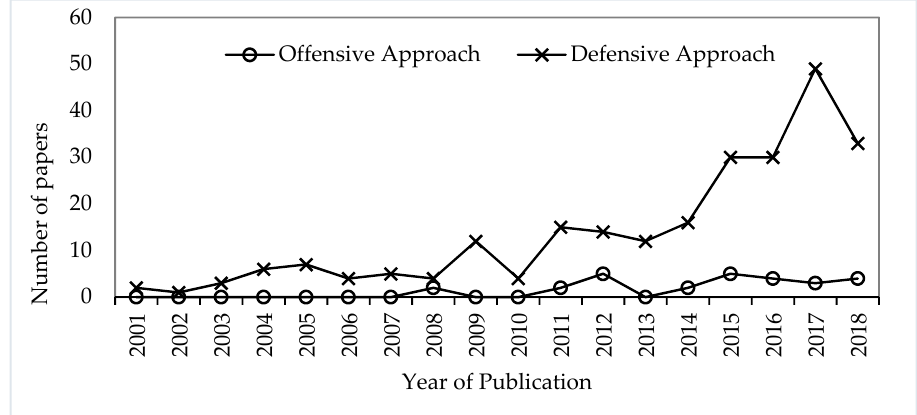
Figure 2. Trend for Machine Learning (ML) -based offensive and defensive approaches in cybersecurity.